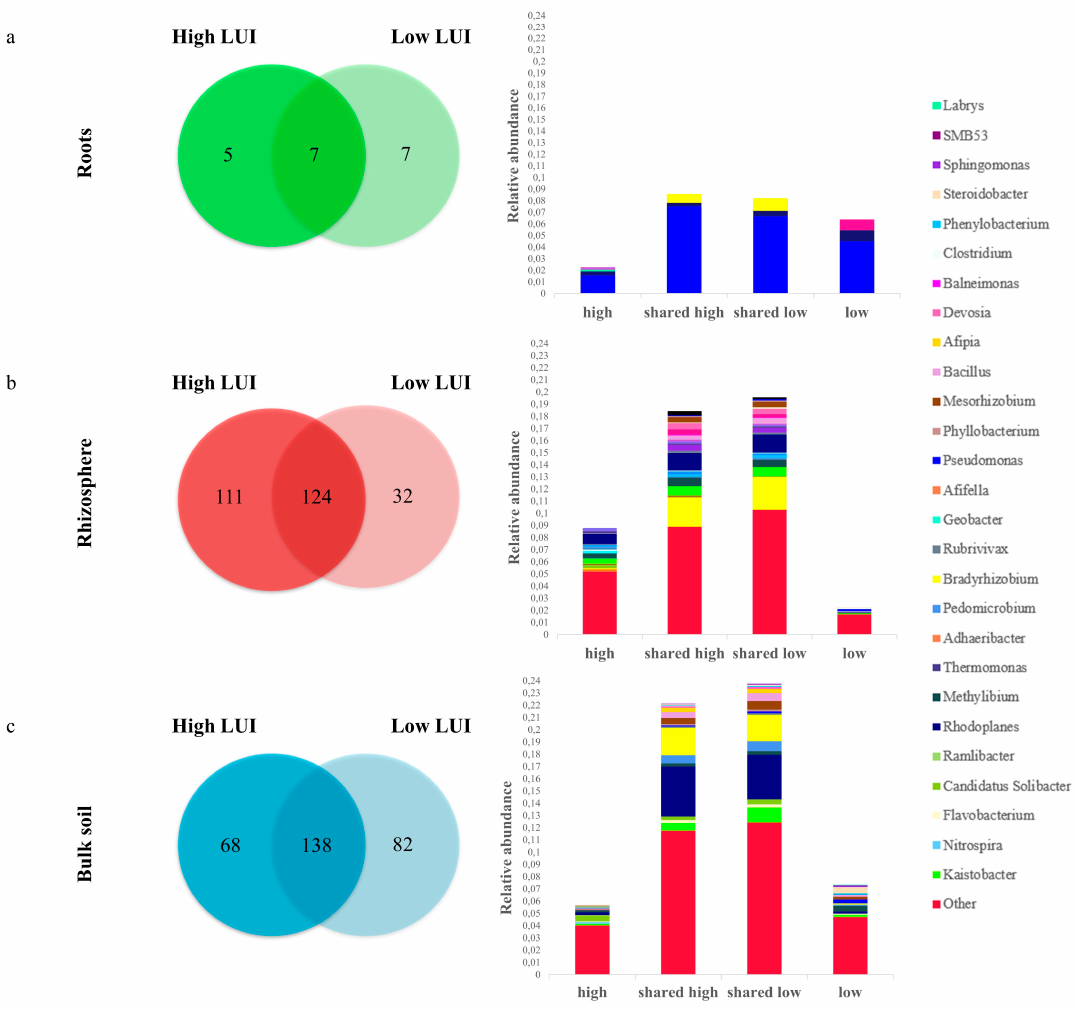
Figure 3. Comparison of plant-associated core bacterial communities. The Venn diagrams show the amount of OTUs that contributed to the core bacterial communities that were shared amongst all seasons only under high and low LUI as well as the core OTUs found under both LUIs and all seasons for roots (green, ( a )), rhizosphere (red, ( b )) and bulk soil (blue, ( c )). The stackplots show the comparison of the total relative abundance of the OTUs that contribute to the core bacterial communities in Figure 3a. “High” refers to the abundance of OTUs found under high LUI only (shared amongst all seasons, but only under high LUI), “shared high” refers to the abundance under high LUI of those OTUs that were found under both LUIs (shared amongst all seasons under high as well as low LUI), “shared low” refers to the abundance under low LUI of those OTUs that were found under both LUIs (shared amongst all seasons under high as well as low LUI), abundance of OTUs under low LUI only (shared amongst all seasons, but only under low LUI), colored by genus. OTUs in “Other” could not be classified to the genus level.